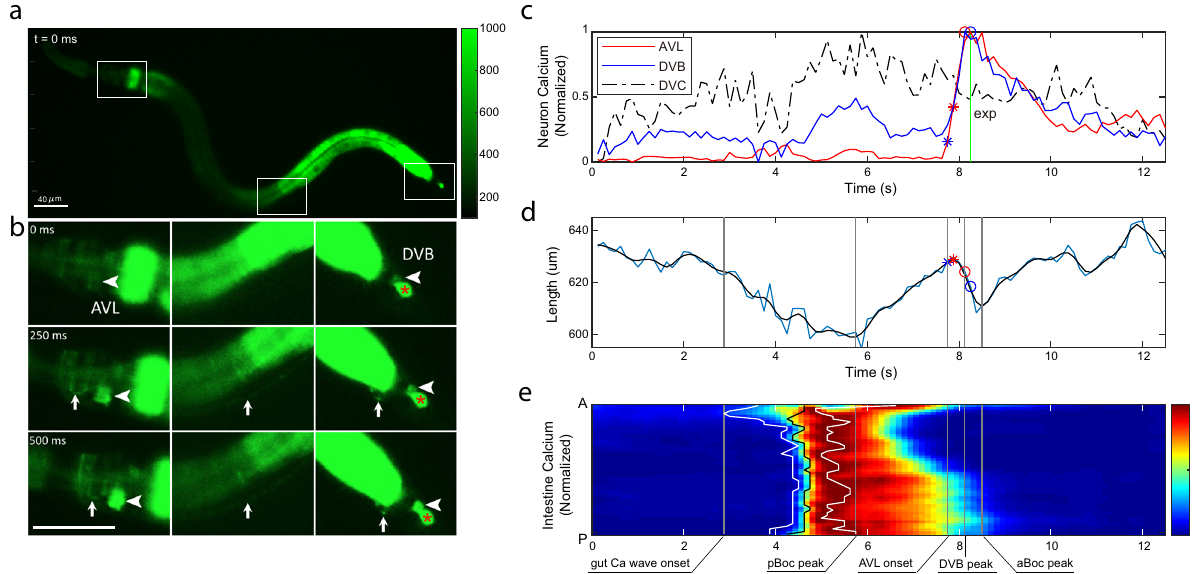
Fig. 5 AVL and DVB synchronously fi re propagating action potentials. a , b Representative images showing synchronous GCaMP fl uorescence in AVL and DVB. Time 0 is an arbitrary frame before neural activation. AVL soma (left panel, arrowhead), AVL axon (left and middle panels, arrow), preanal NMJs (right panel, arrow), DVB soma (right panel, arrowhead). Same scale bar for a , b . This imaging strain also has GCaMP expressed in DVC (marked by a red * in the right panel) which is irrelevant to DMP but used as a negative control. 13 imaging experiments were done with similar results. c Representative (normalized) calcium activities in AVL (red), DVB (blue), and DVC (black) soma. All activities normalized with maximum set to 1. Vertical line and markers: The timing of expulsion (green vertical line), the onset (asterisk), and the peak (circle) of AVL and DVB spikes. d Corresponding worm body length as a function of time. The blue curve is frame-by-frame and black is a smoothed version of the blue curve. (Smoothing used local regression to a second-order polynomial.) Red and blue asterisk/circle: same as in c . e Corresponding (normalized) intestinal calcium activities along the worm body axis (A: anterior, P: posterior). Curves (from left to right): the timing of the onset (white), the half-peak (black), and the peak (white) of calcium activities along the worm body axis. Vertical lines in d , e (from left to right): the earliest onset of intestinal calcium activity, the peak of pBoc, the onset of AVL, the peak of DVB, and the peak of aBoc. Source data are provided as a Source Data fi